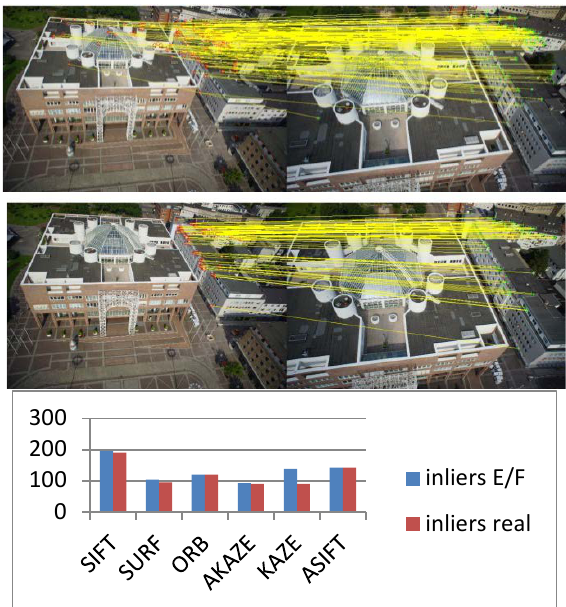
Figure 6: pair-4 results. Upper: ASIFT matches, lower: for each number of matches after E-/and F-based filtering (blue) and real inliers (red)